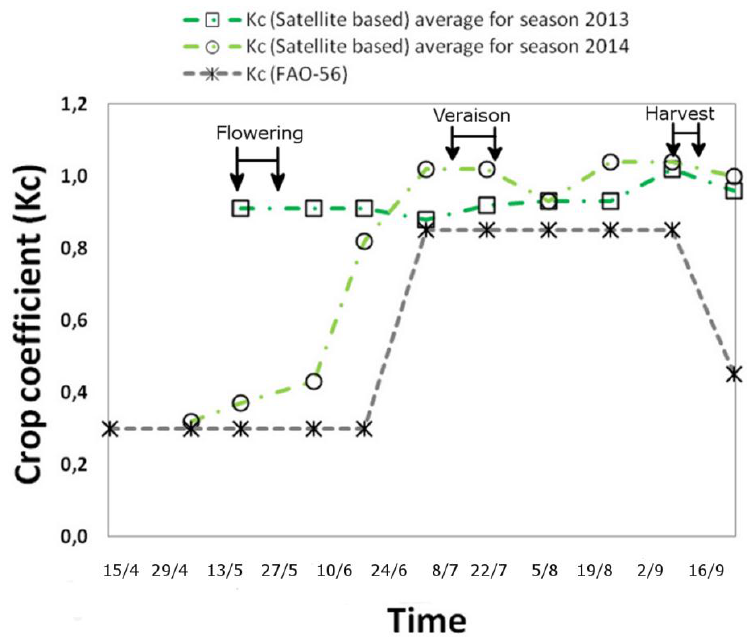
Figure 7. Comparison of Kc (average) estimated from remote sensing data (Landsat 8) and K c from the FAO-56